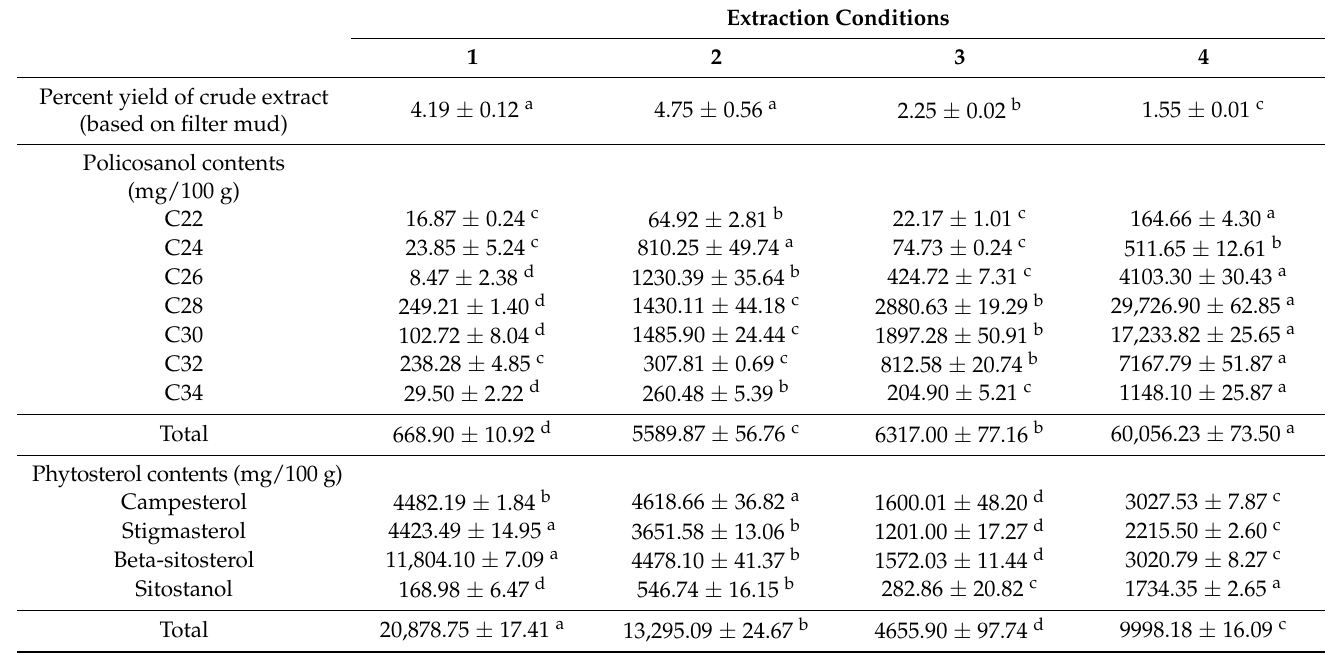
Table 4. Policosanol and phytosterol contents of filter mud with different pretreatments before extraction by SUBFE with